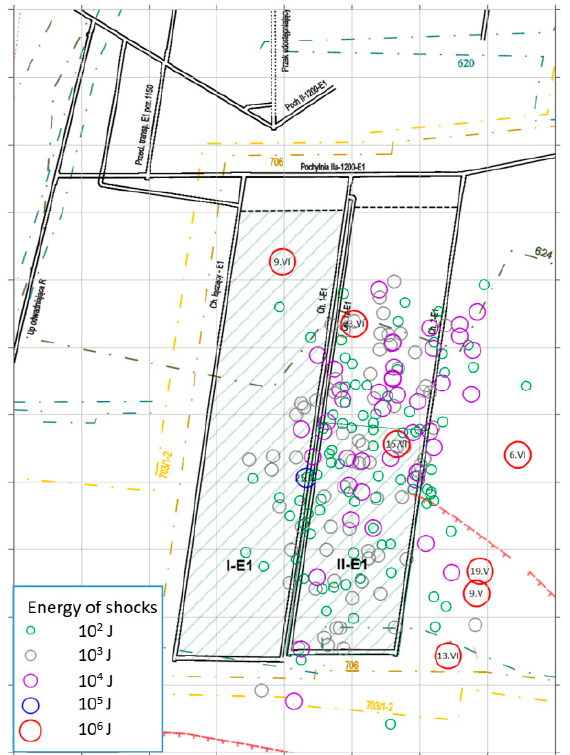
Figure 2. The placement of seismic activities during the exploitation of coal seam 713/1-2 at longwall II-E1 until July 9th 2017 (the first hydraulic fracturing date).